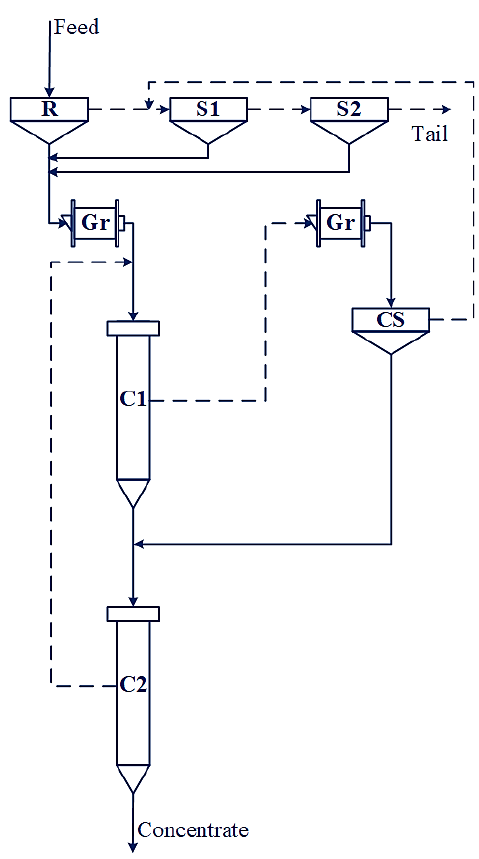
Figure 7. Structure 2 using columns in the cleaner and recleaner stages, with copper price uncertainty described by U(3000,4000) USD/t.